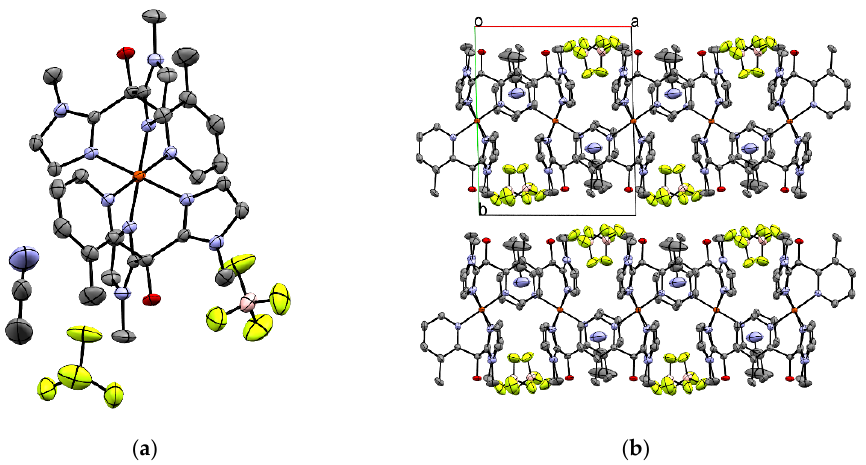
Figure 3. ( a ) Molecular structure of [Fe((mim) 2 (mpy)COH) 2 ](BF 4 ) 2 · 0.5MeCN ( 2 ). ( b ) Stacking of infinite chains of interacting [Fe((mim) 2 (mpy)COH) 2 ] 2+ molecules along the b -axis with a clear view on the nitrilic nitrogen interacting with the pyridine in the ligand through n → π * Ar interactions. On cations parallel to the c -axis, stabilized through an n → π * Ar interaction between the